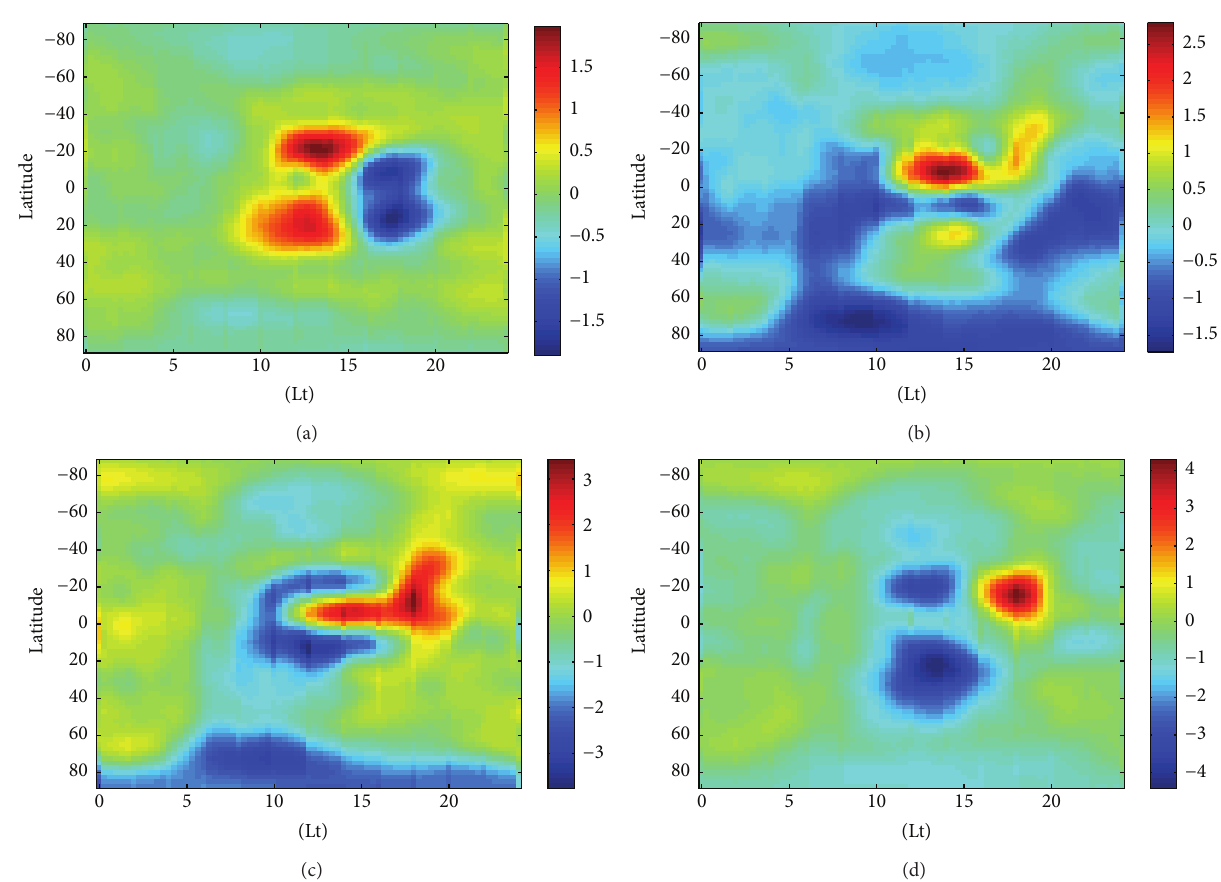
Figure 2: Error distributions by nonlinear forecasting based on genetic algorithm.